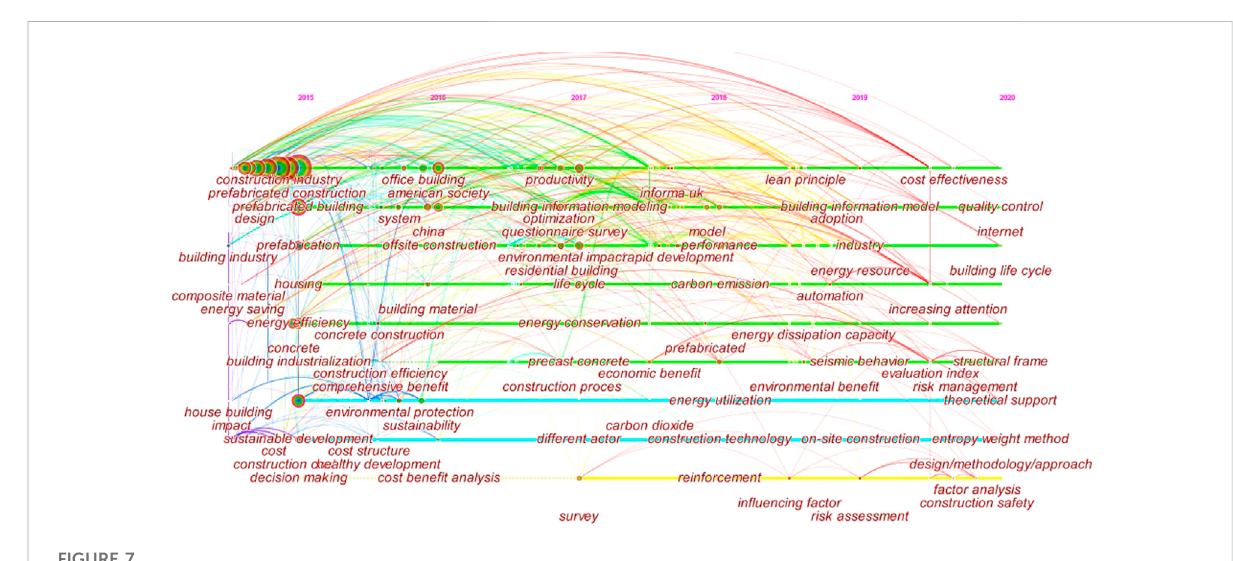
FIGURE 7 Keywords timeline analysis.